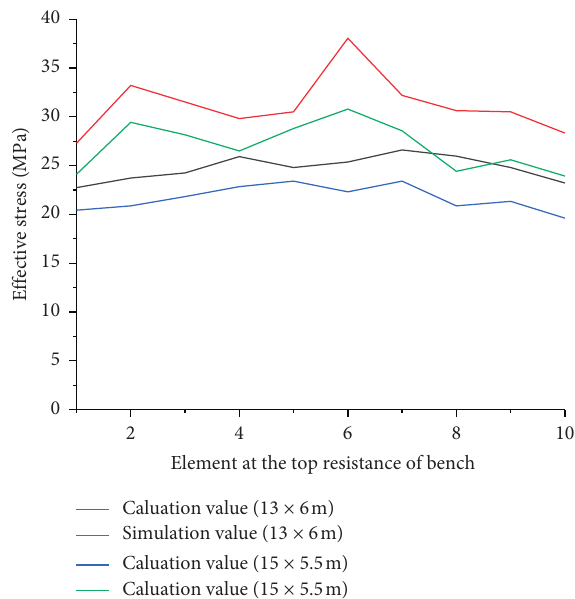
Figure 16: Effective stress of the section at the top resistance of bench.